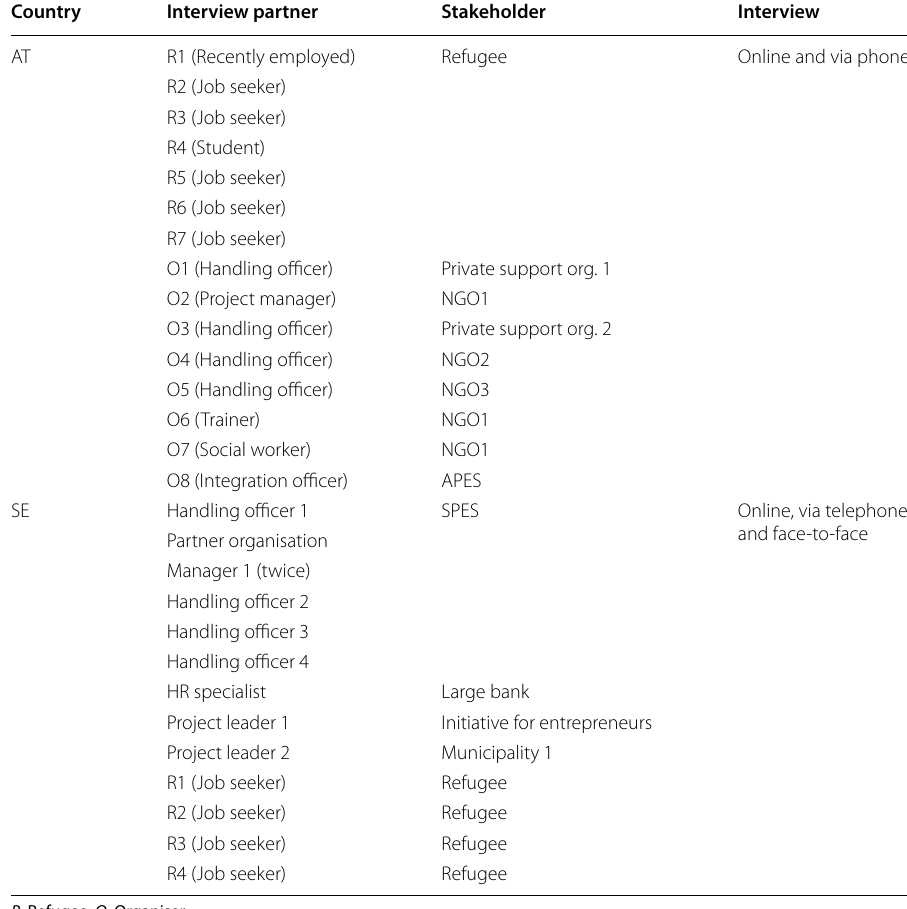
R , Refugee; O , Organiser